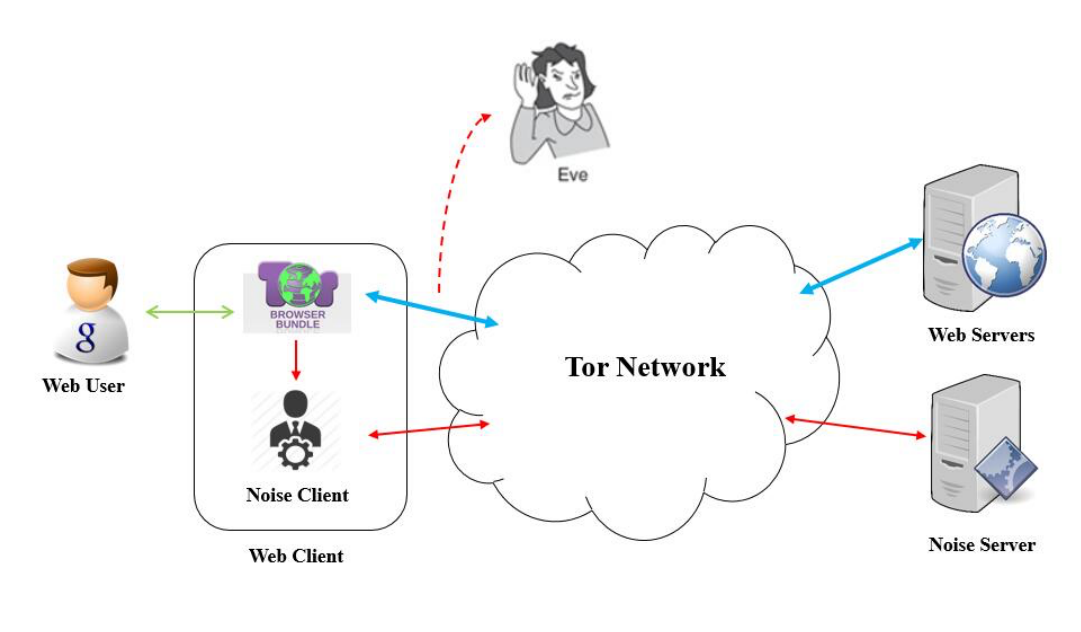
Figure 1. Our system model and experimental